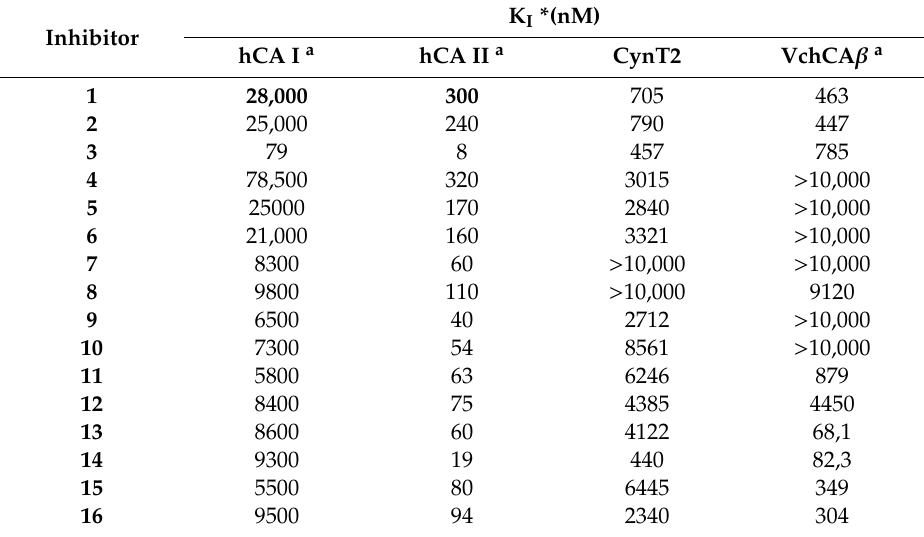
Table 3. Inhibition of the human isoforms hCA I and hCA II and the two bacterial β -CAs (CynT2